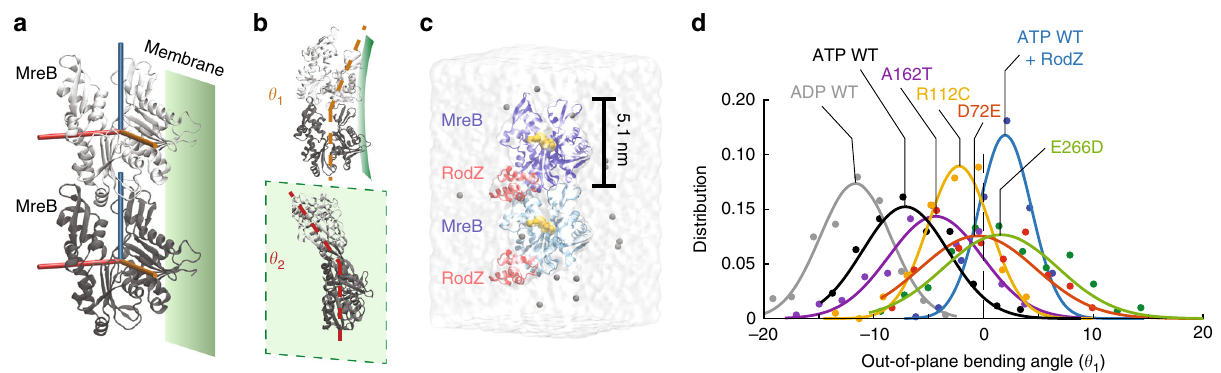
Fig. 4 RodZ binding and MreB mutations may alter the bending properties of MreB fi laments. a Schematic of an MreB dimer (PDB ID: 1JCG) and its orientation relative to the membrane. The bending of MreB proto fi laments is captured by the relative orientation along three orthogonal axes (cylinders) of adjacent MreB subunits, colored light (top) and dark gray (bottom). The membrane binding interface of the MreB proto fi lament is shown as a green plane. b Schematic of MreB dimer bending angles out of the plane of the membrane ( θ 1 , top) and in the plane of the membrane ( θ 2 , bottom). In the crystal structures that form the initial states of our MD simulations, these bending angles are zero. c MD simulation system comprised of a nucleotide-bound T . maritima MreB dimer, with each subunit bound to the cytoplasmic tail of RodZ. d D72E, R112C, A162T, and E266D mutations in ATP-bound T . maritima MreB shift the θ 1 bending angles toward that of a RodZ-bound ATP dimer, signifying fi lament